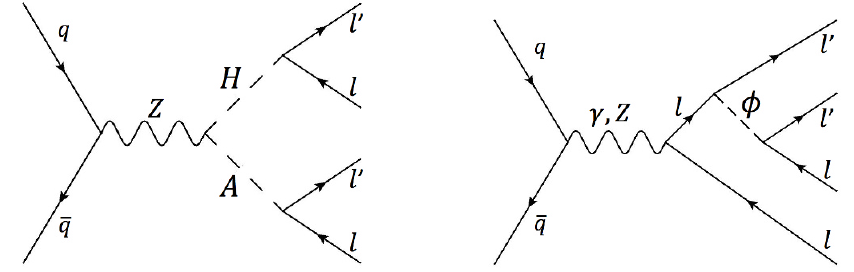
Figure 2 . The representative diagrams contributing to the 4 lepton channel in our